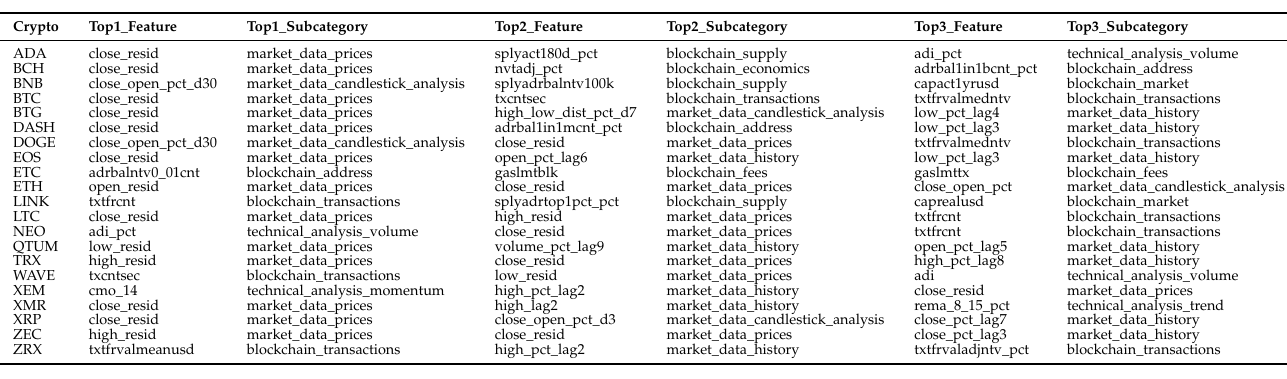
Table 3. Most influential features for class Uptrend.